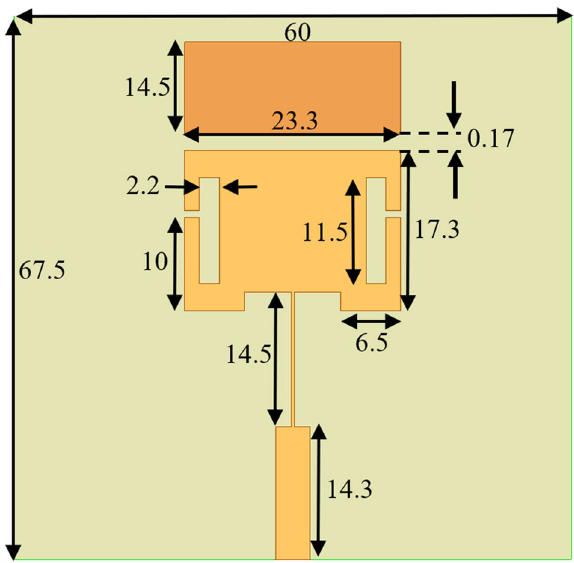
Figure 1. The designed antenna sensor for ice detection. All of the dimensions in this figure are measured in millimeters